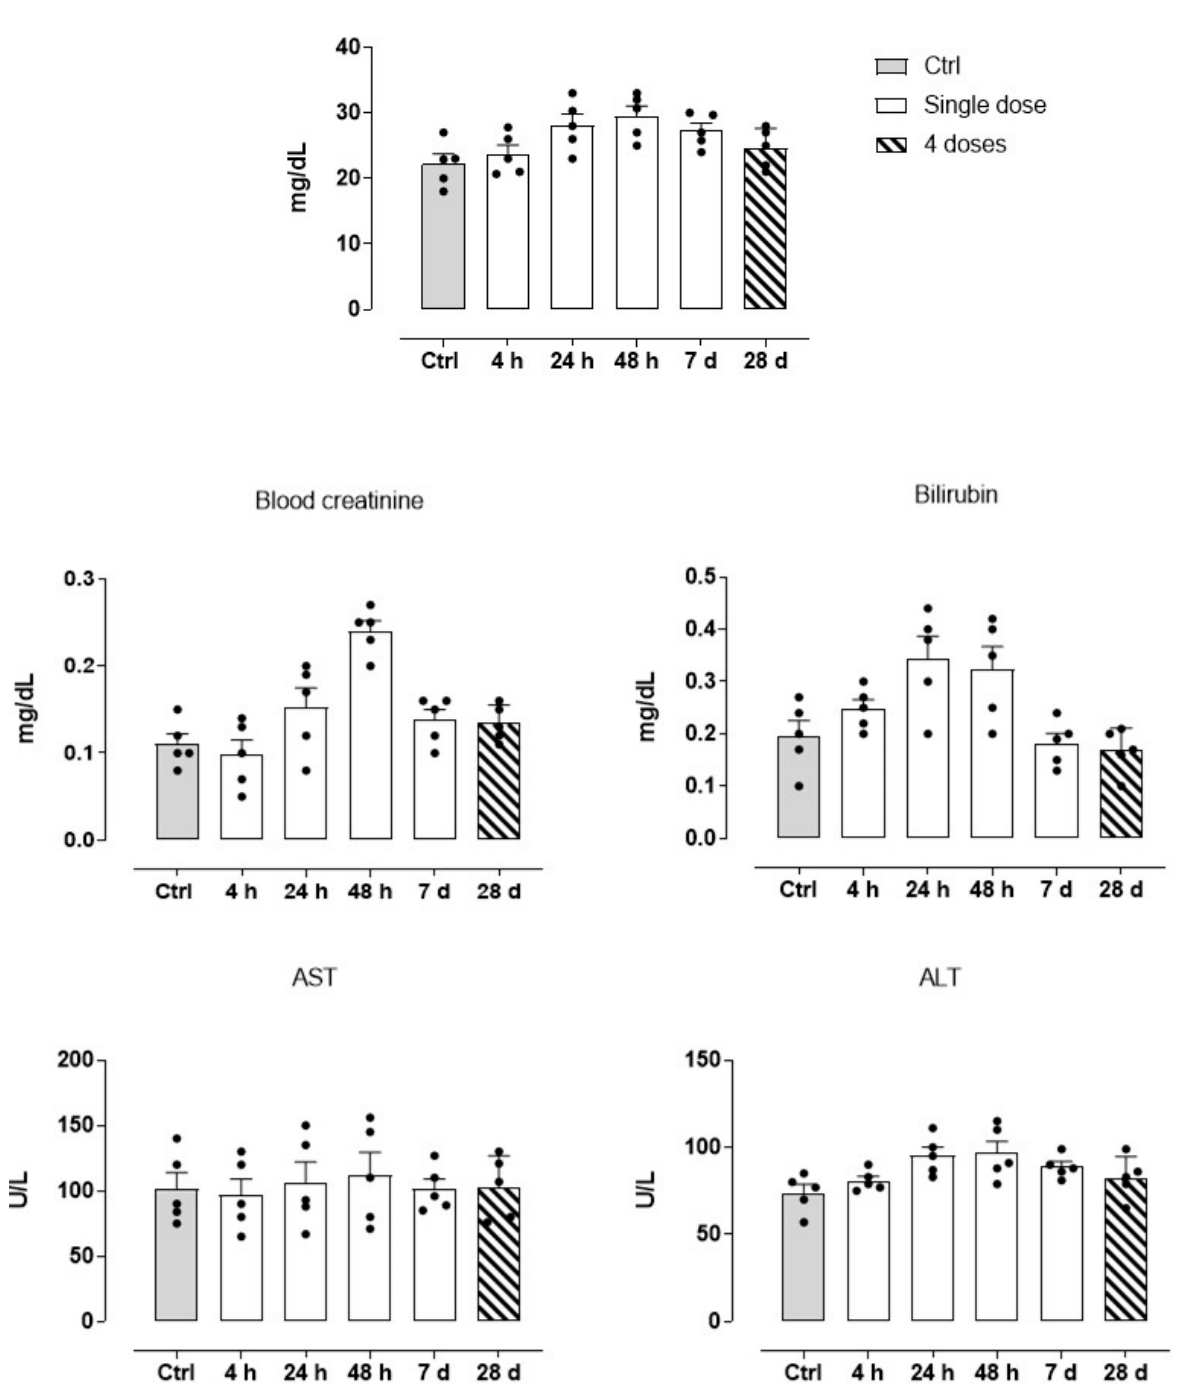
Figure 6. Haematological investigations on blood samples after 4, 24, and 48 h, and 7 days (white bars, “Single dose”) from a single HoThyRu/DOTAP dose (15 mg/kg, i.p. ), and after weekly administrations (ribbed bars, “4 doses”) of HoThyRu/DOTAP (15 mg/kg, i.p. , once a week for 4 weeks), showing the indicated biochemical markers ( n = 5 animals per time point). Values from control group (non-xenotransplanted mice) were used as reference values and are plotted in graphs as grey bars. Statistical analysis was conducted by one-way ANOVA followed by Bonferroni’s for multiple comparisons.